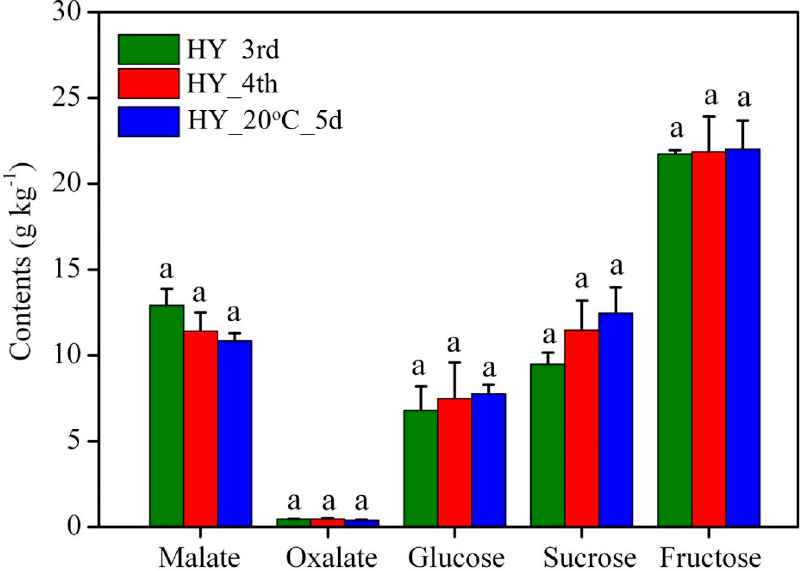
Figure 1. Variation of malate, oxalate, glucose, sucrose and fructose content in pre ‐ ripening (HY_3rd), ripening (HY_4th) and post ‐ ripening (HY_20 °C_5) ‘Hongyu’ Apple fruit. The error bars represent the standard errors. The significant differences were calculated at the 0.05 level.